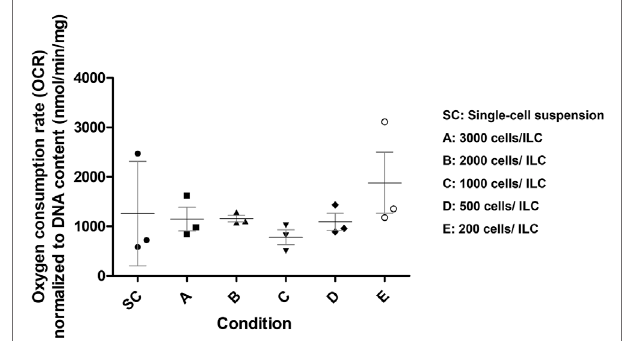
FIGURE2| Mouseinsulinoma6(MIN6)oxygenconsumptionrate(OCR) normalized to DNA content. OCR was measured for MIN6 islet-like clusters (ILCs) generated using different seeding densities in AggreWell ™ 400 microwell plates. Conditions are SC = single-cell suspension (control); A = 3,000 cells/ILC; B = 2,000 cells/ILC; C = 1,000 cells/ILC; D = 500 cells/ILC; E = 200 cells/ILC. Using a one-way analysis of variance, no signi fi cance differencewasobservedbetweenthemeansofconditions( p =0.5041).N=3 biological replicates. Error bars represent the standard deviation.